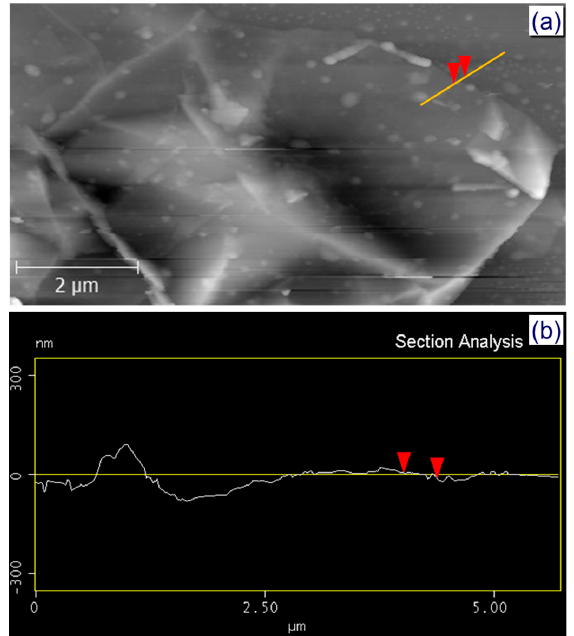
Figure 4. ( a ) Atomic force microscopy (AFM) images of graphene nanoplatelets and ( b ) the height profile calculated from AFM imagery.